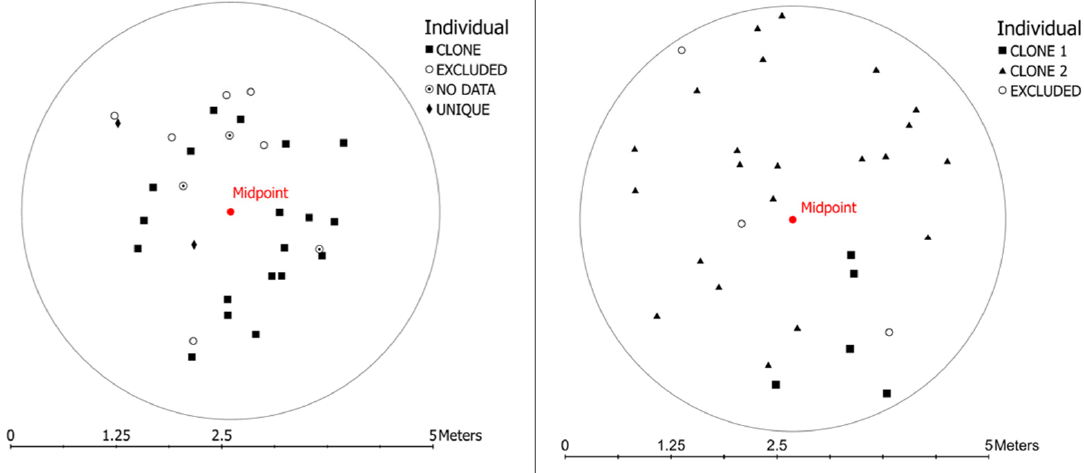
Figure 7. Scutellaria floridana clone identification (squares and triangles) and genetically unique individuals (diamonds) in 5m circular plots established in ANF4 ( left , N = 21) and SJSBP2 ( right , N = 28). Each plot was 5 m in diameter, with a midpoint selected randomly in an area displaying high stem density. Excluded individuals (open circles) in each plot were missing 45% (ANF4) or 25% (SJSBP2) of SNPS. Individuals with no data (circle with dot) were excluded from analyses.